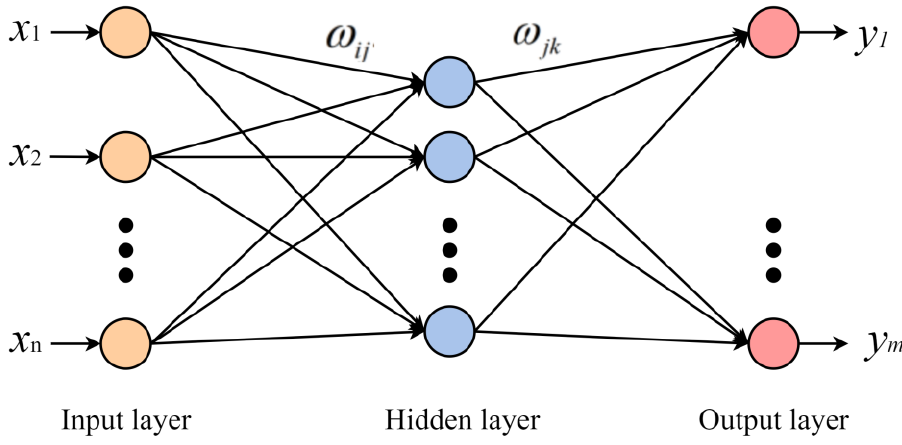
Figure 7. Topology structure of BP neural network model.